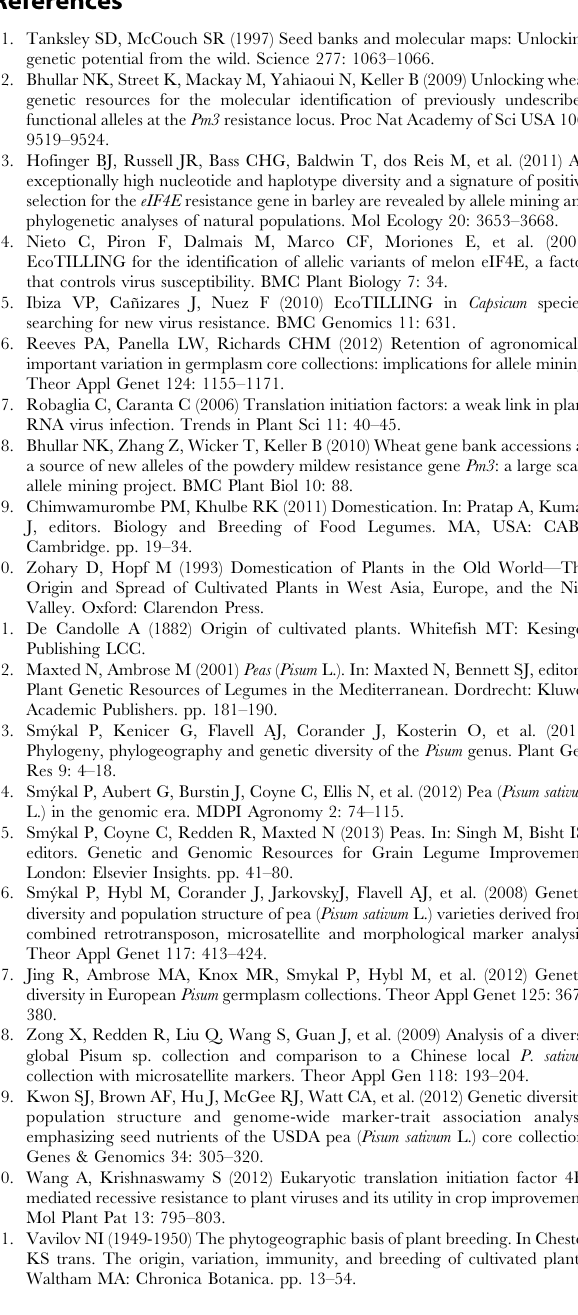
Table S1 List of studied accessions, divided by 7 studied germplasm collection with indicated accession number, name, origin and eIF4E variant. (XLSX) Table S2 Table of sequenced 73 accessions indicating single-nucleotide polymorphic (SNP) sites in exons and introns (SNP sheet) as well as resulting amino acid exchanges (protein sheet). Species name, germplasm, country of origin and eIF4E allele asignment are shown. Length of all introns and exons is shown in base pairs, with variable intron 3 being highlighted. Results of virological testing with P1 PSbMV